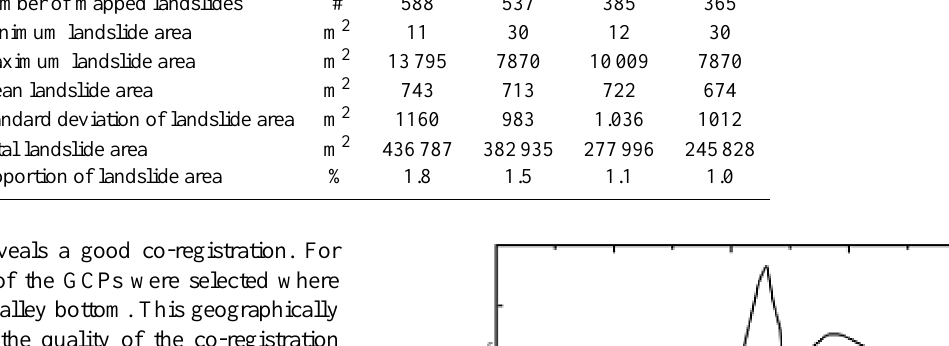
Figure 3. Event landslide inventory maps. (A) Photo-interpreted (PI) event landslide inventory map obtained through the visual interpretation of post-event orthophotographs and digital aerial photographs. (B) Semi-automatic (SA) event landslide inventory map obtained through the analysis of a post-event WorldView-2 satellite image. Table 1. Statistics for the two original event landslide inventories. (A) Photo-interpreted landslide inventory map, PI, (B) semi-automatic landslide inventory map, SA, (C) photo-interpreted landslide inventory map without soil slips, (D) semi-automatic landslide inventory map without soil slips.